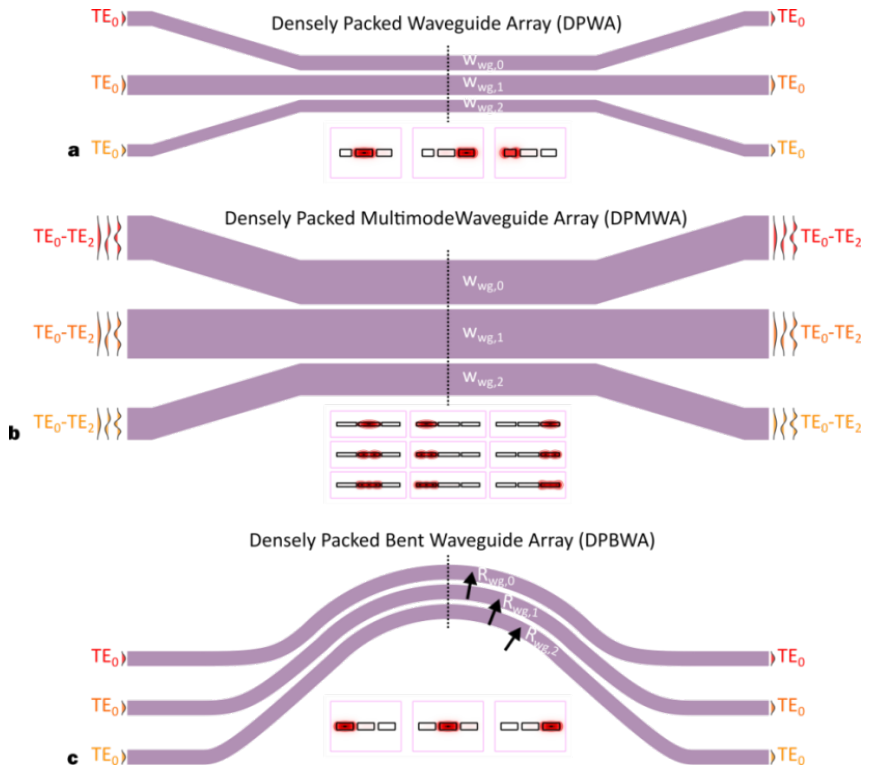
Figure 10. The schematics for the silicon ( a ) densely packed waveguide array (DPWA) [154,157] , ( b ) densely packed multi-mode waveguide array (DPMWA) [158] and ( c ) densely packed bent-waveguide array (DPBWA) [159,160] .